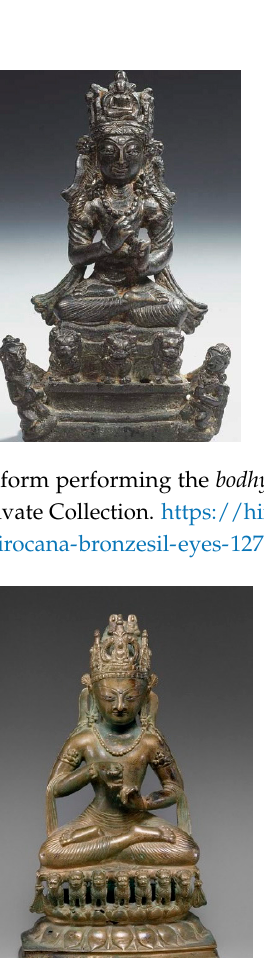
Figure 28. Vairocana in sambhogak ā ya form performing the bodhy ā gr ī mudr ā , eighth to ninth c. Swat. Copper alloy with silver inlay. Private collection.